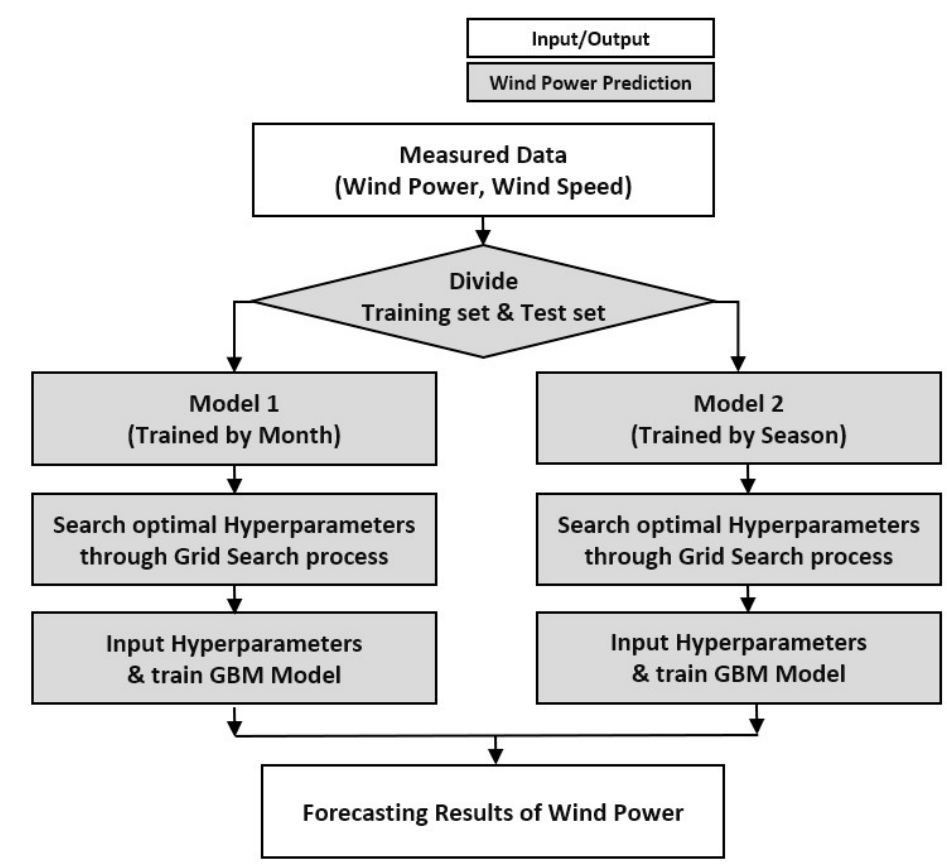
Figure 1. Flow chart of the GBM forecasting model.